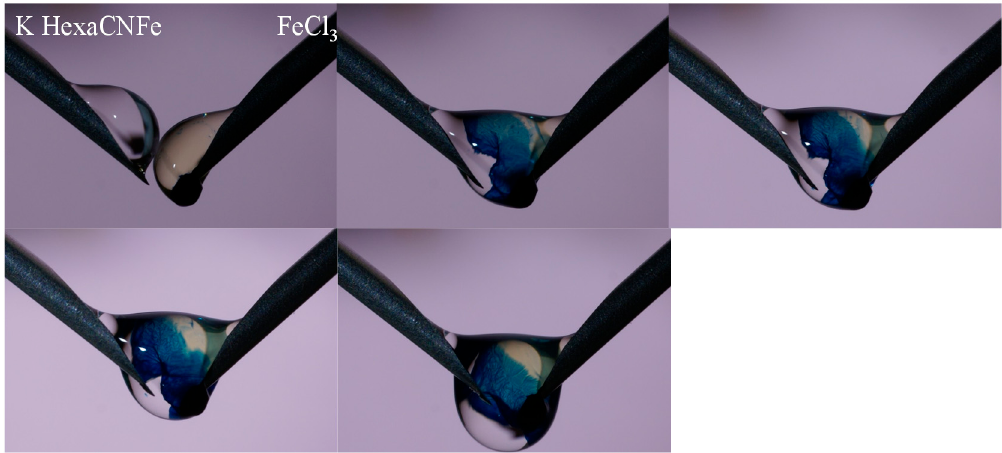
Figure 1. “In-drop” synthesis of Prussian Blue.